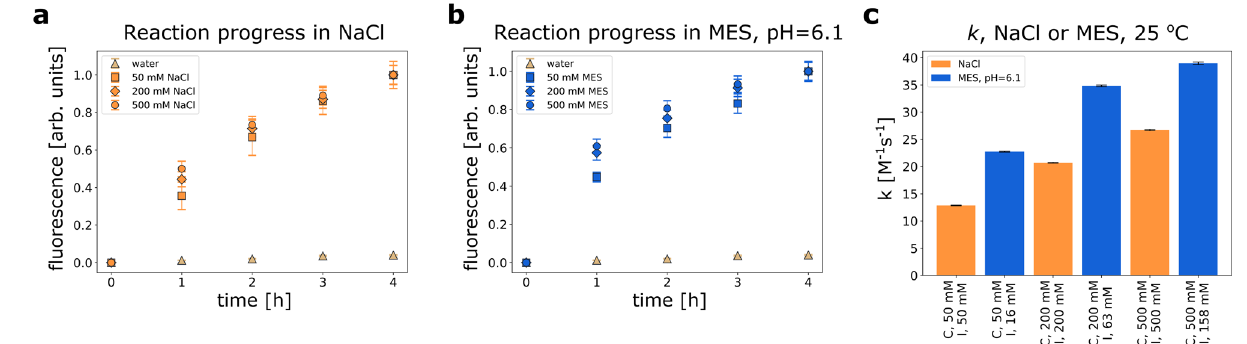
Fig. 2 | Reactioninthepresenceofionsand zwitterions. Reaction progress over timebetween10 μ MCoAand10 μ MCoA-Minthepresenceof a sodiumchlorideor b MESbufferpH6.1and c theirreactionrateconstants, T =25°C.Despitethelower ionic strength of the solution, zwitterions (MES) better accelerate the reaction